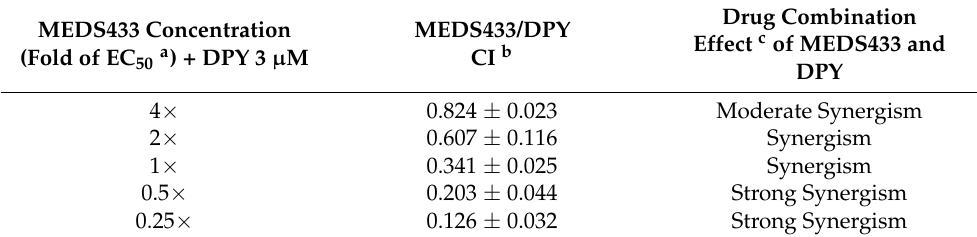
Table 2. Analysis of the effects of the combination of MEDS433 and DPY against IAV replication.